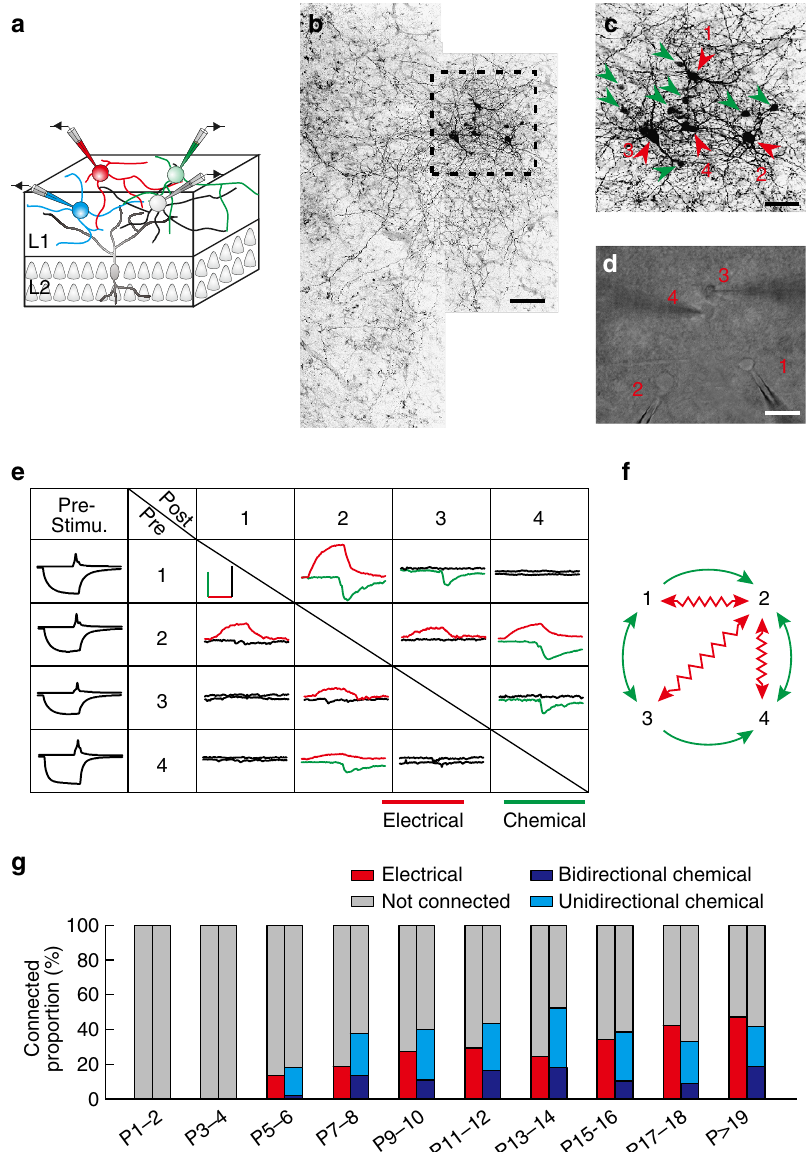
Figure 1 | Development of electrical and GABAergic connections between interneurons in neocortical layer 1. ( a ) A schematic diagram of a quadruple whole-cell recording of four neurons in cortical layer 1. ( b ) An image of four layer 1 neurons filled with neurobiotin during recording and labelled with fluorescence-conjugated avidin. Scale bar, 100 m m. ( c ) A magnified image of b (dotted rectangular region). Red arrowheads indicate the four recorded neurons, and green arrowheads indicate dye-coupled neurons. Scale bar, 50 m m. ( d ) A DIC image of quadruple whole-cell recording of the four neurons in layer 1 shown in b and c . Scale bar, 50 m m. ( e ) Summary of the synaptic connections detected in this quadruple recording. The average traces of the postsynaptic responses are shown in the rectangle. Red traces indicate the existence of electrical synapses, and green traces indicate the existence of chemical synapses. Sample traces of AP and hyperpolarization potentials are shown to the left. Scale bar, 40pA (green vertical scale bar), 20ms (red horizontal scale bar), 200mV (black vertical scale bar). ‘Pre-Stimu.’, presynaptic potential; ‘Pre’, presynaptic neuron; ‘Post’, postsynaptic neuron. ( f ) A schematic diagram showing connections between the four neurons in e . Wavy red arrowheads indicate electrical connections, and green arrowheads indicate chemical connections. ( g ) Summary of proportion of electrical connections (red bars) and unidirectional/bidirectional chemical connections (light blue bars for unidirectional chemical connections and dark blue bars for bidirectional chemical connections) between interneuron pairs in neocortical layer 1 at different postnatal